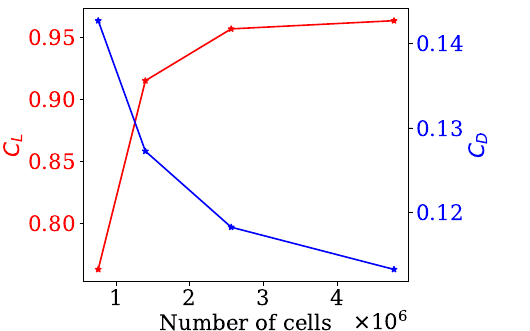
Figure 10. Lift and drag coefficient versus the number of cells in the component mesh.